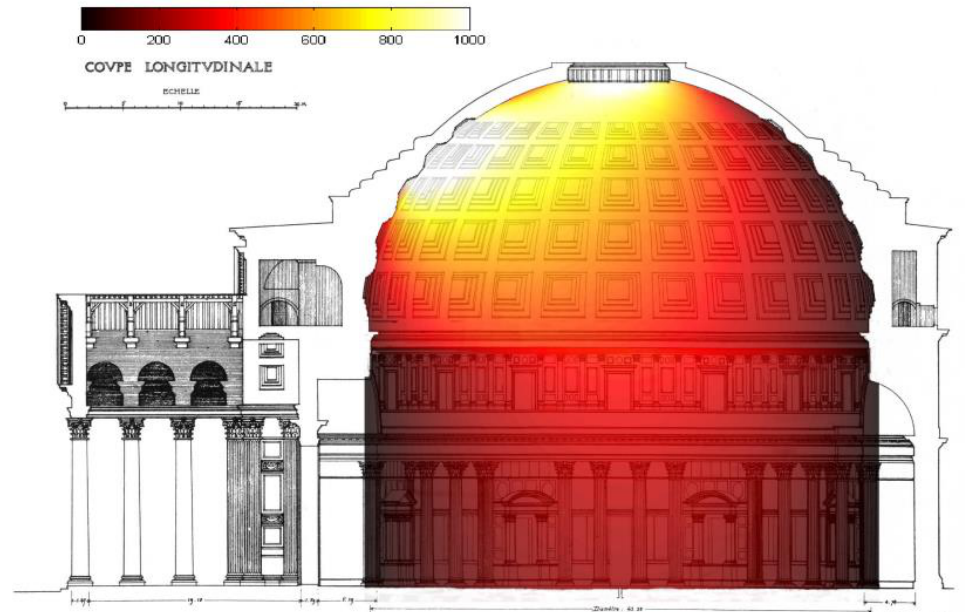
Figure 3. The Roman Pantheon ’s lighting simulation values in Lux. Source: Cabeza-Lainez.